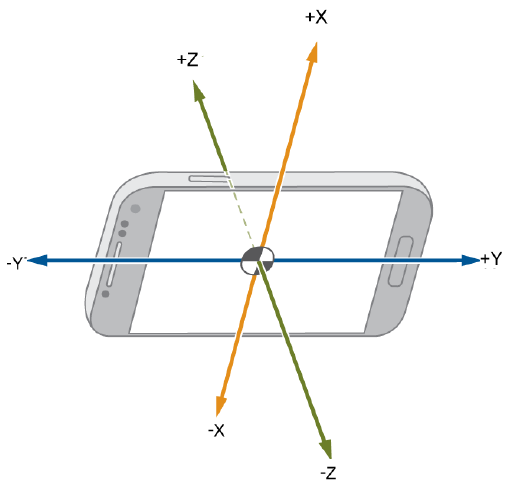
Figure 6. Accelerometer axes’ orientation during the data collection